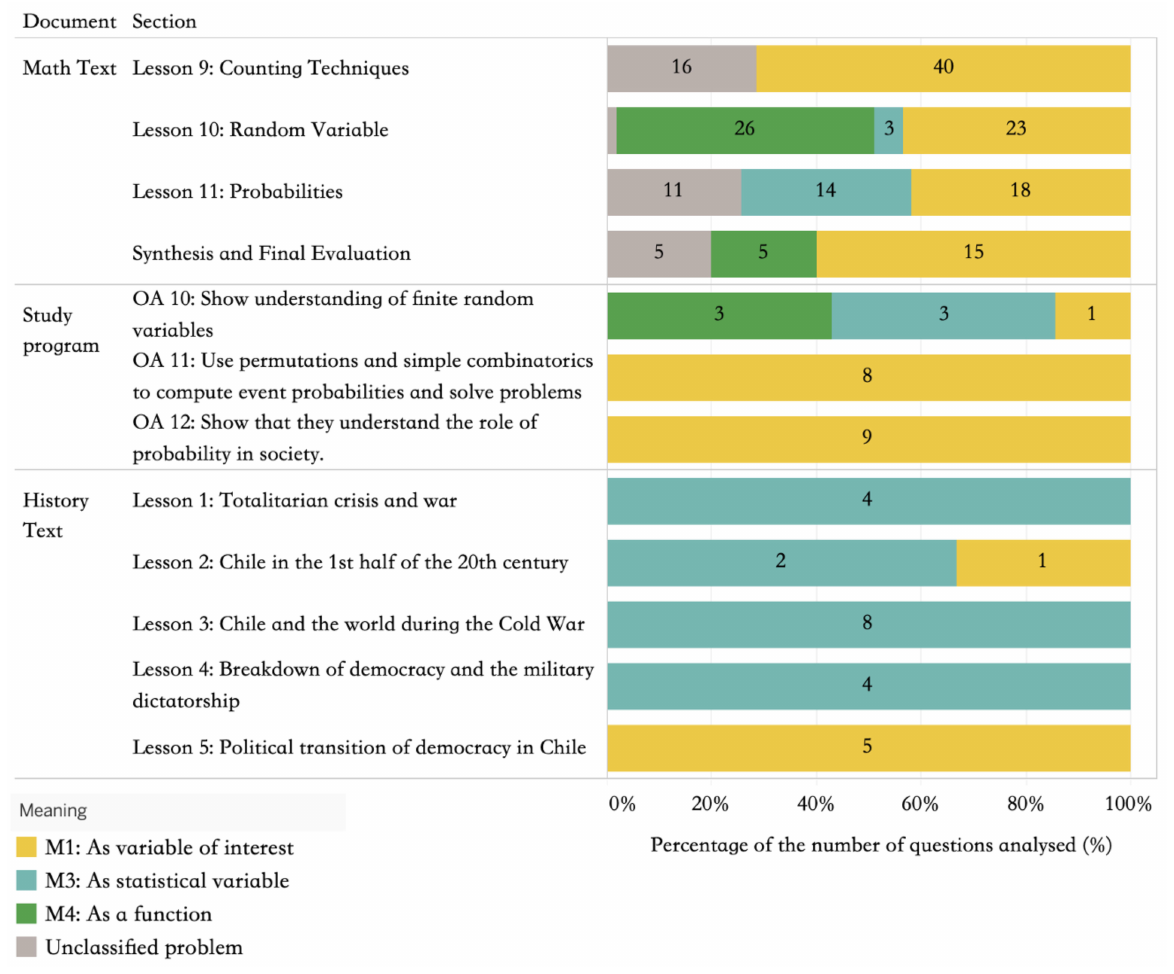
Figure 5. Percentage distribution of meanings in texts and programme of study (Source: Prepared by the authors).